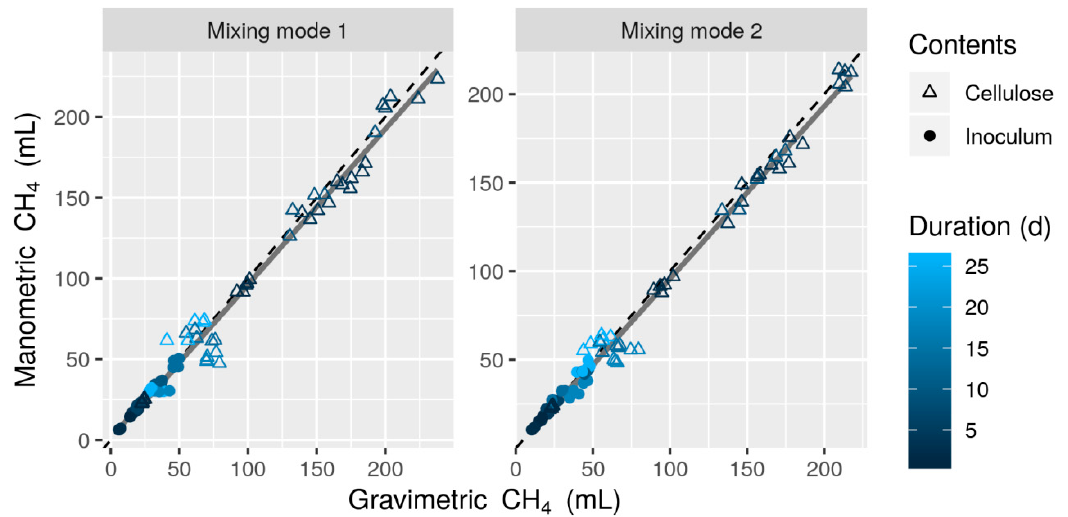
Figure 5. Comparison of the interval methane volume produced by each bottle as measured by manometric vs. gravimetric methods. Color shows the duration of the incubation at the time of measurement. The solid gray lines show regression lines for the two separate mixing modes, while the black dashed lines show a 1:1 response.